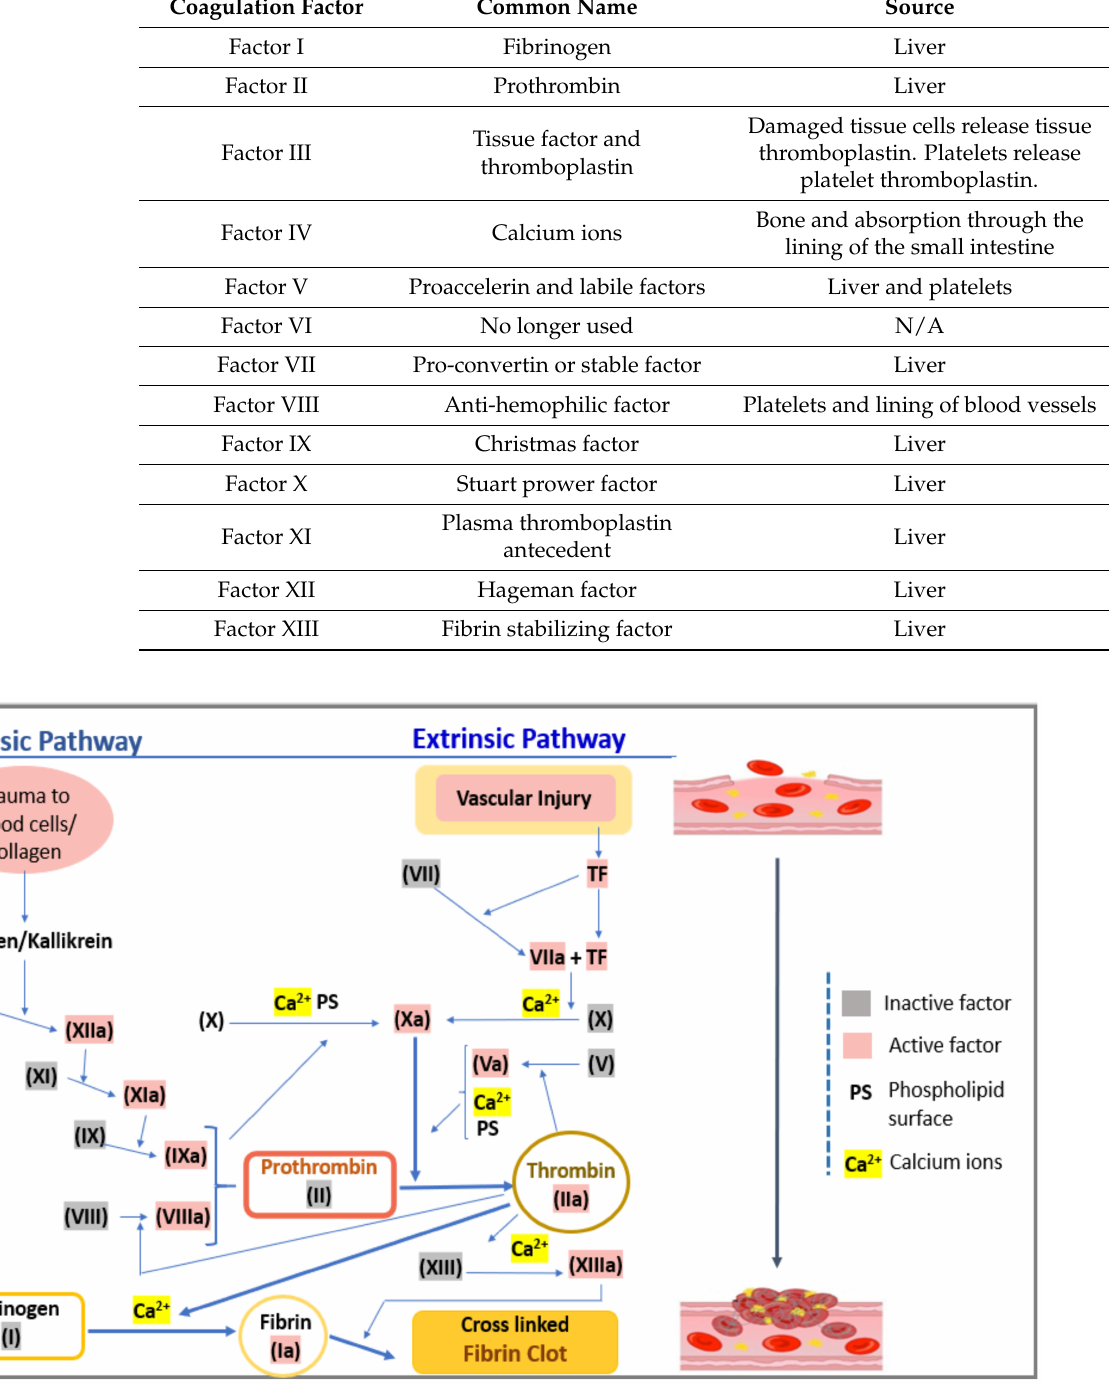
Figure 3. Schematic of Waterfall coagulation